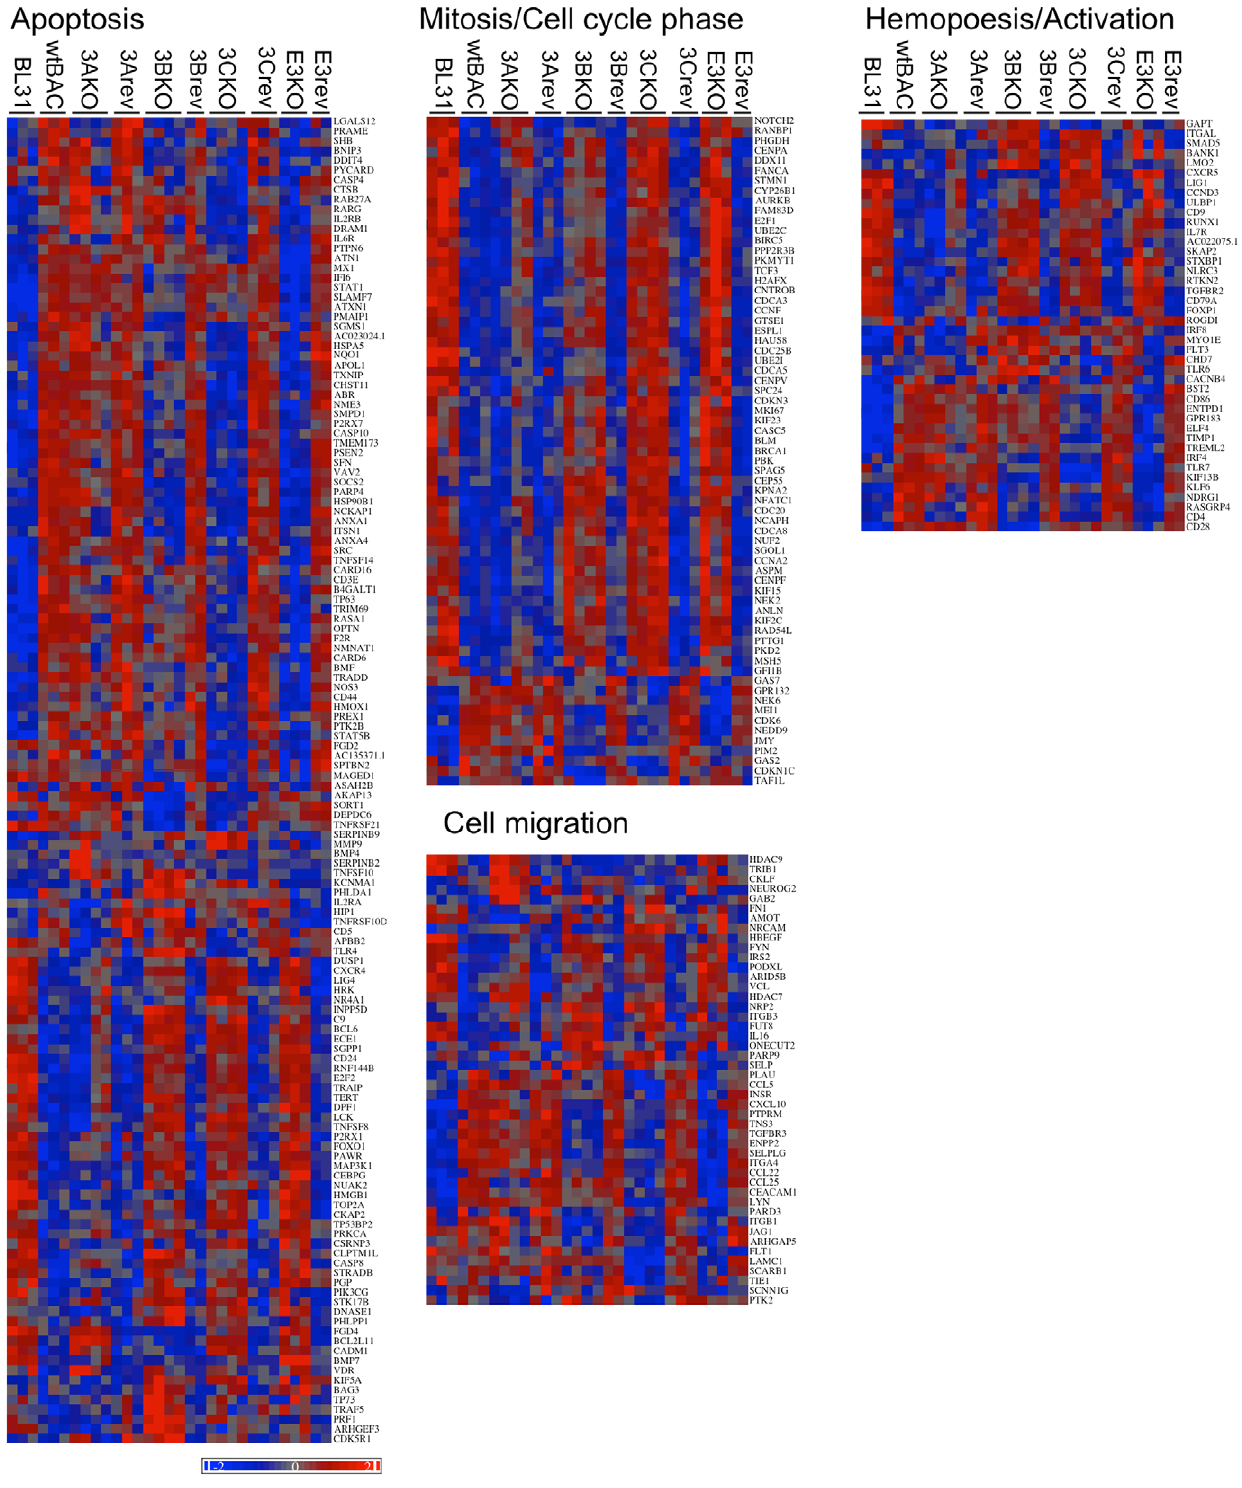
Figure 3. Relative expression of differentially regulated genes falling into significant ontological groups. MMBGX-extracted gene expression levels were normalised to the mean and scaled by the standard deviation of the gene expression level for each gene – colour coding ranges from + 2 to 2 2 standard deviations (see scale bottom left). These were grouped by ontological term, and where genes fell into multiple groups, they were placed in the group in the following order – Mitosis, apoptosis, cell migration, hemopoesis and activation. Genes within each group were ordered by unsupervised clustering.